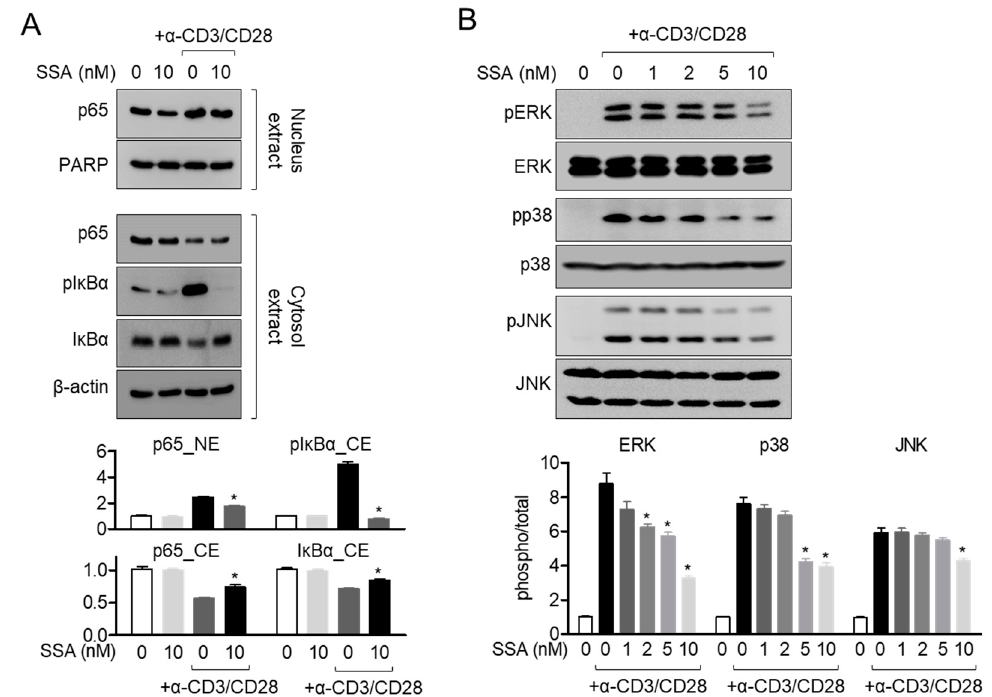
Figure 7. Treatment with 10 nM salinosporamide A dampens the MAPK pathway in activated T cells. ( A ) Nuclear-translocated p65 and phosphorylated or degraded I κ B α from activated Jurkat T cells pre-treated with 10 nM salinosporamide A were detected by western blot analysis. Separation of nucleus extract from the whole lysates was performed using the NE-PER kit. Nuclear protein was normalized to the expression of PARP, and cytosol protein was normalized to the expression of β -actin. ( B ) The phosphorylation levels of ERK, p38, and JNK from activated Jurkat T cells pre-treated with the indicated concentration of salinosporamide A were detected by western blot analysis. All phosphorylation levels were normalized to the total levels of each respective protein and presented in a bar graph. The mean value of three experiments ± SEM is presented. * p < 0.05 between control cells.